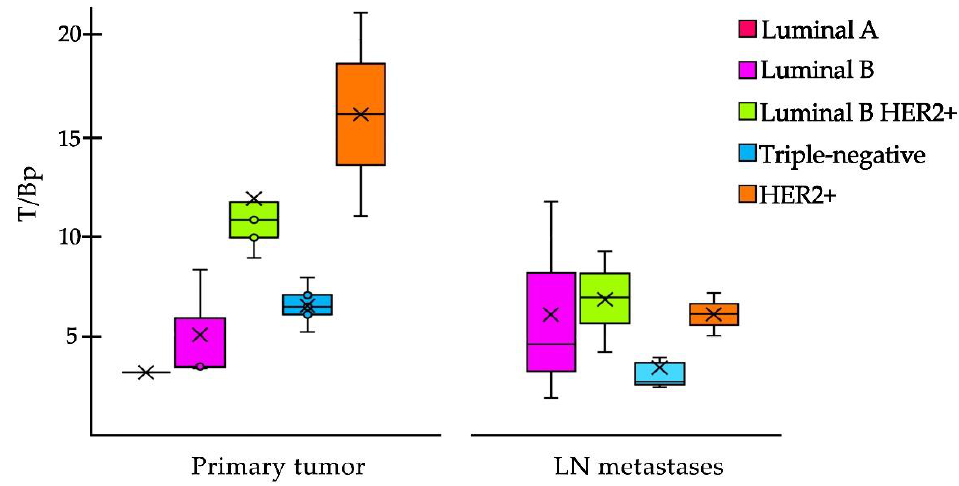
Figure 7. Box plot of the T/Bp ratio of [ 99m Tc]Tc-iFAP in primary tumors and LN metastases of breast cancer. In primary tumors, the T/Bp (tumor/psoas muscle) ratio is higher in HER2+ and Luminal B HER2+ molecular subtypes. In LN metastases, a decrease in T/Bp is observed and there is no significant difference among the molecular subtypes (Pearson correlation coefficient: r = 0.4027). ×= mode and ° = outliers.